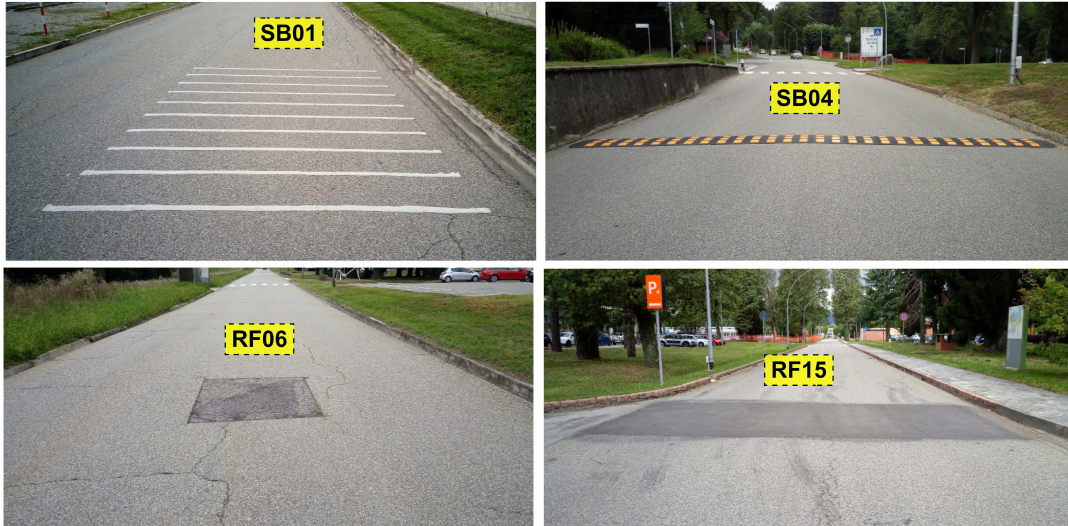
Figure 3. Examples of obstacles and road anomalies